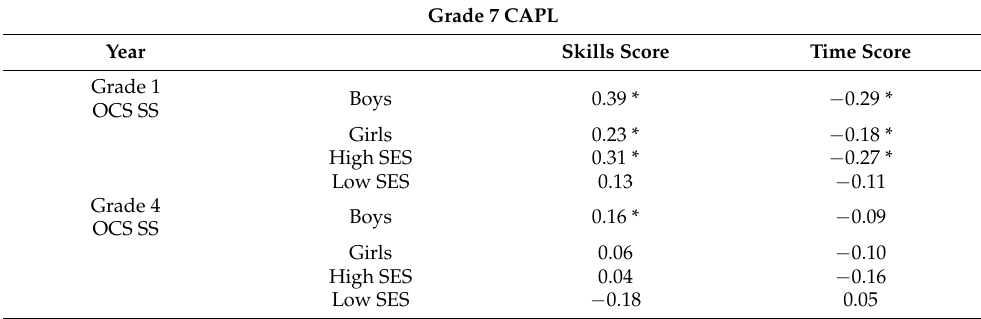
Table 3. Correlations between OCS SS, and the CAMSA skills and time scores (Grade 1, 4, and 7).